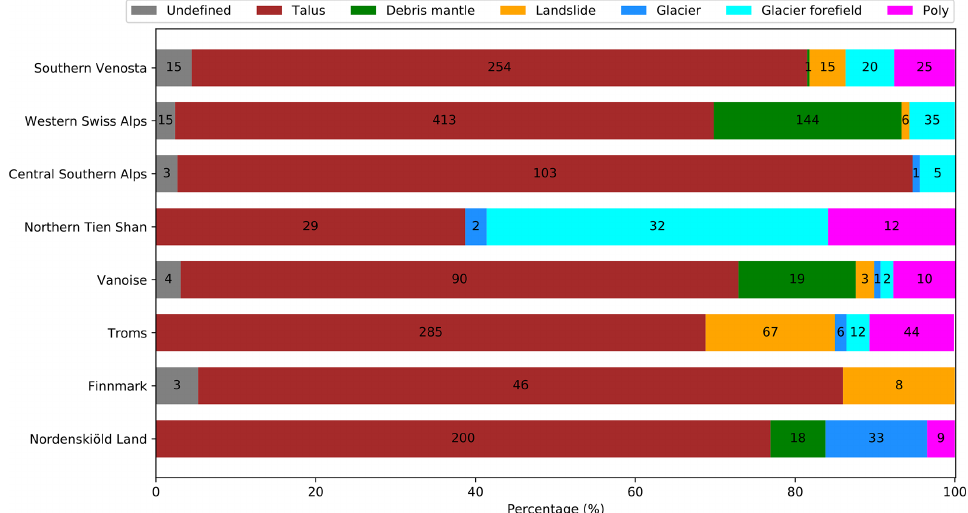
Figure 10. Upslope connection classes for most of the investigated regions. The size of the horizontal bars is proportional to the percentage ( x axis), and the values inside the bars are the numbers for each upslope connection class. The Disko Island and Brooks Range regions are not shown because of lack of high-resolution optical data needed to document this attribute. The Central Andes region is not shown because of many cases with undefined upslope connection.